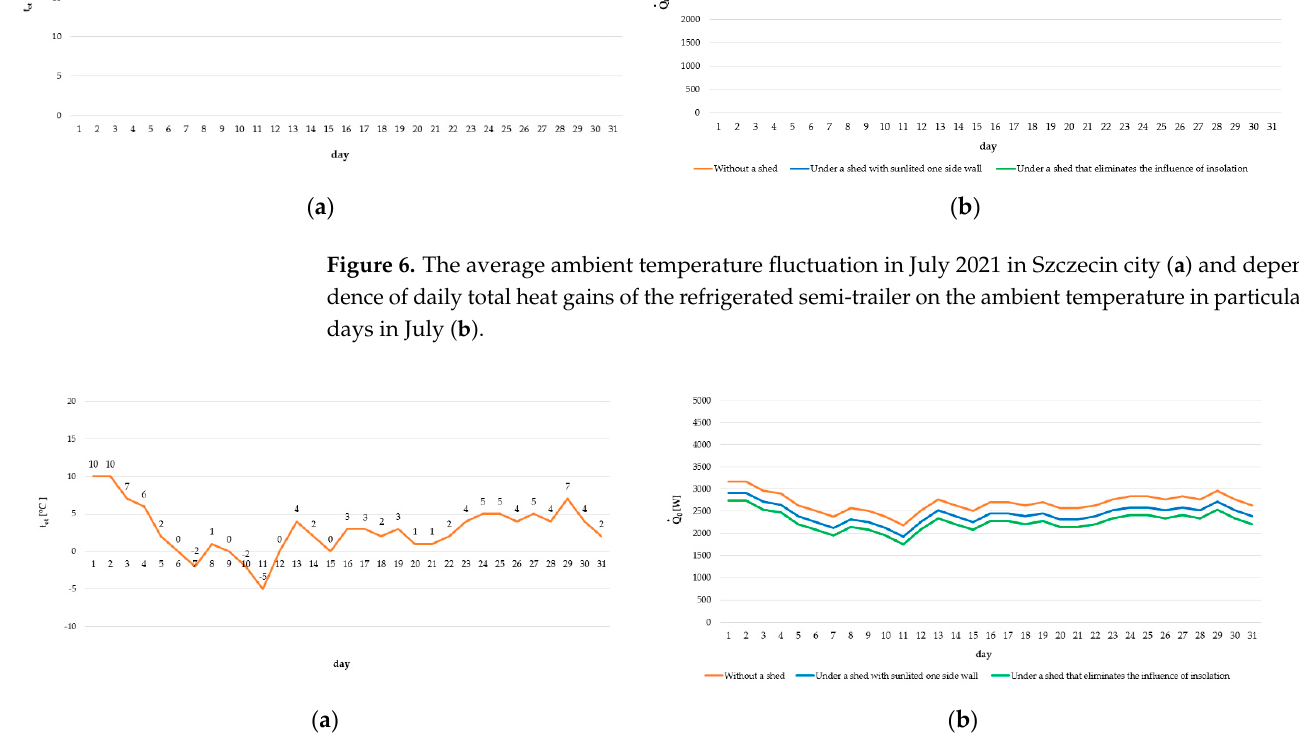
Figure 7. The average ambient temperature fluctuation in January 2022 in Szczecin city ( a ) and de- pendence of daily total heat gains of the refrigerated semi-trailer on the ambient temperature in particular days in January ( b ).